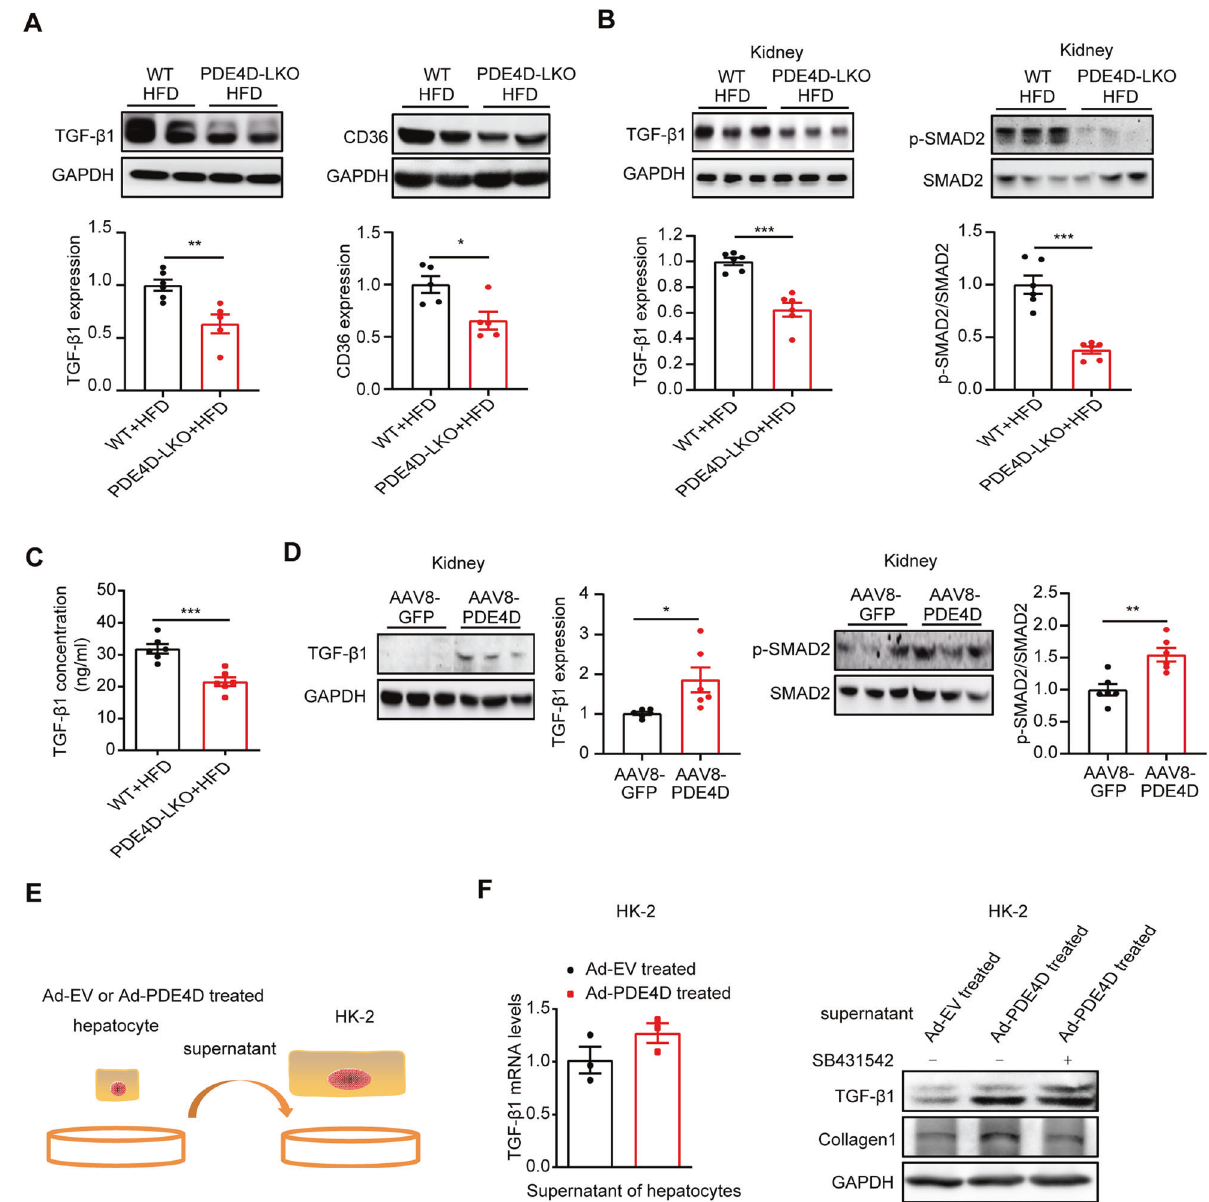
Fig. 5 Hepatic PDE4D mediated NAFLD-associated renal injury through the TGF- β 1 pathway. A The protein levels of TGF- β 1 and CD36 in the livers of WT and PDE4D-LKO mice. B The protein levels of TGF- β 1, p-SMAD2, and SMAD2 in the kidneys of WT and PDE4D-LKO HFD mice. C The concentration of TGF- β 1 in the serum of WT and PDE4D-LKO mice fed with HFD for 16 weeks was detected by ELISA. D The protein levels of TGF- β 1, p-SMAD2, and SMAD2 in the kidneys of AAV8-GFP and AAV8-PDE4D mice. E , F HK-2 cells were treated with the supernatant of hepatocytes infected with PDE4D adenovirus (PDE4D-Ad) or empty adenovirus (EV-Ad). SB431542 was used to inhibit TGF- β 1 signaling. The mRNA levels of TGF- β 1 in HK-2 cells were detected by RT-qPCR. The expression of TGF- β 1 and collagen1 were detected by western blot. Data are shown as the means ± SEMs. * P < 0.05, ** P < 0.01, *** P < 0.001 with a two-tailed Student ’ s t